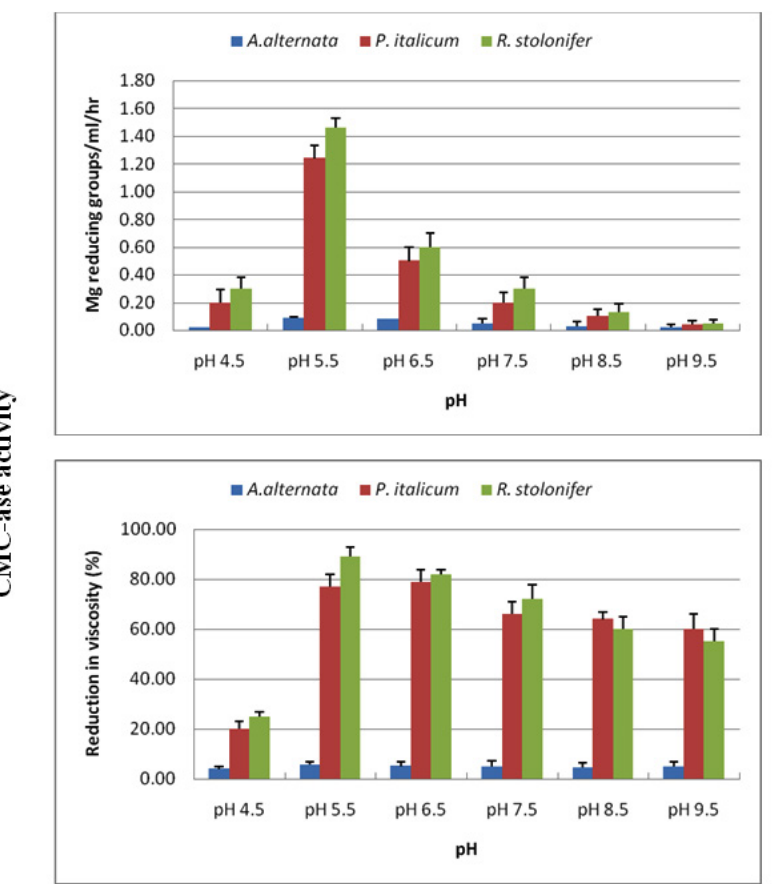
Fig. 5. Effect of incubation pH on production of CMC-ase using Czapek Dox medium amended with cellulose as carbon source for A. alternata , P. italicum and R. stolonifer after 8 days incubation at 28 ºC in the dark. All the data are the mean of three replications and Bar on each column represents the standard